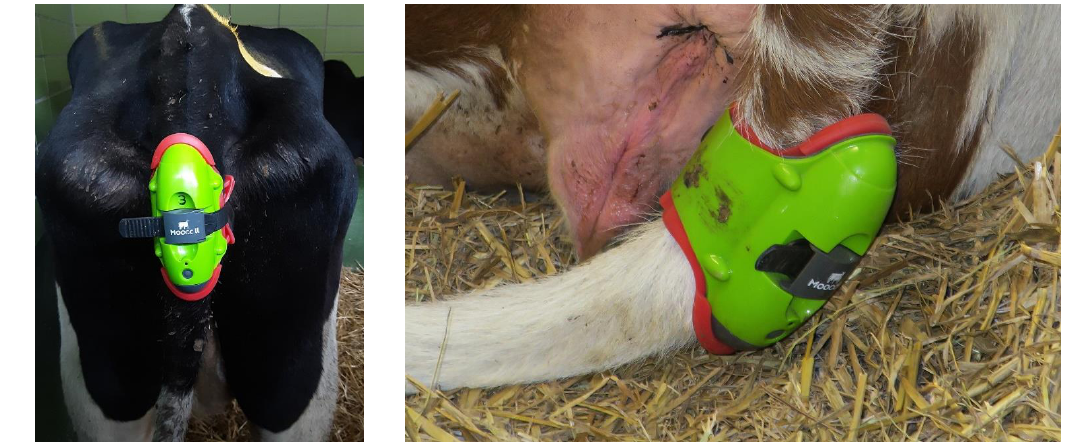
Figure 1. The Moocall ® (Moocall Ltd., Dublin, Ireland) remote calving sensor attached to the tail of late pregnant cows.